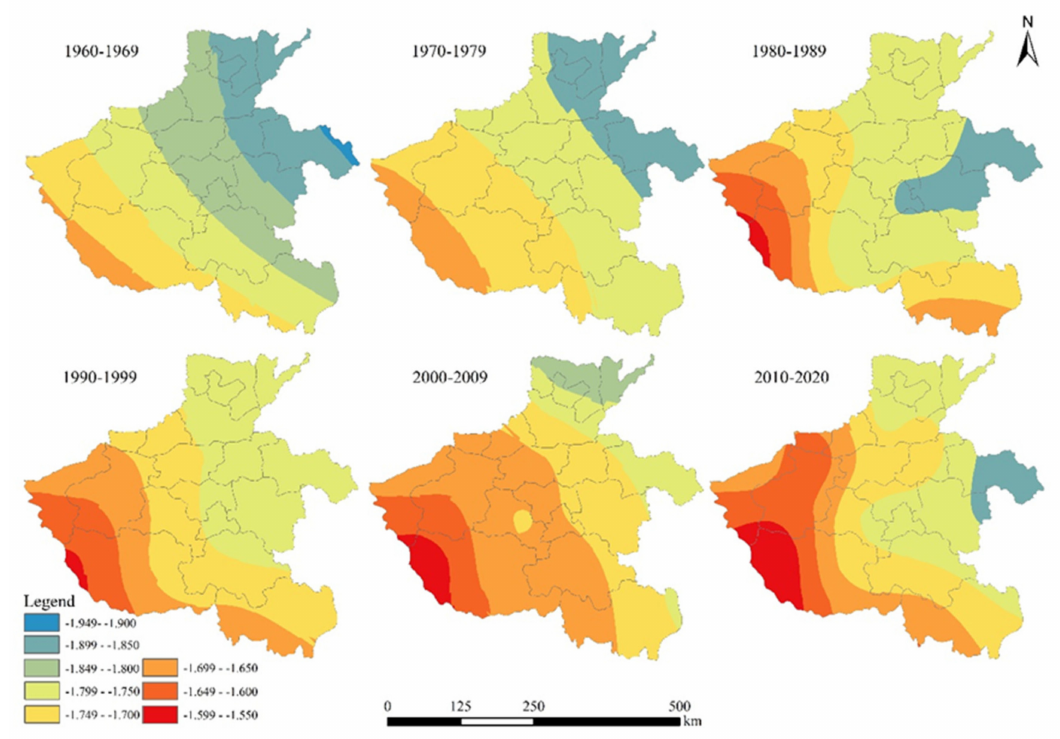
Figure 6. Spatial variation of the TCCI in Henan Province on 10-year scale.